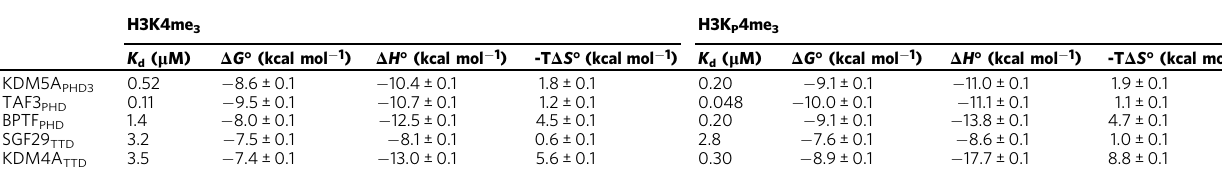
Table 1 Thermodynamic parameters for association of H3K4me 3 and H3K P 4me 3 peptides (ART(Kme 3 /K P me 3 )QTARKS) with fi ve human reader domains a .